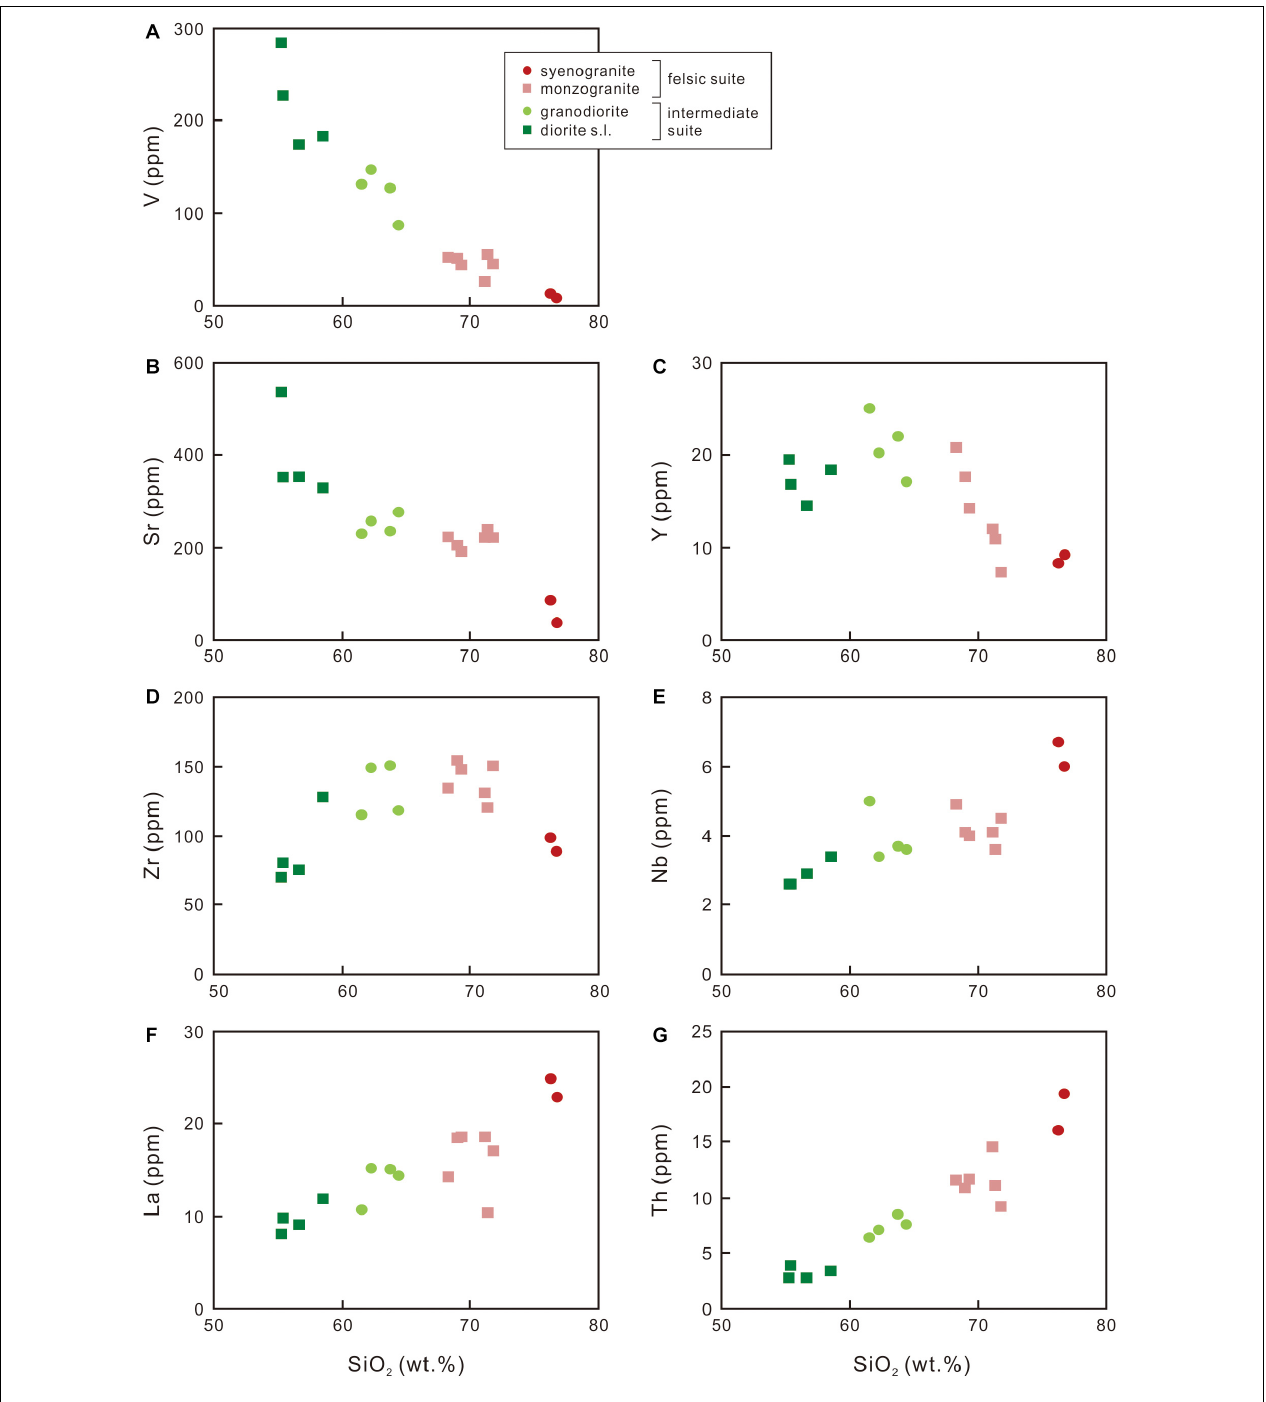
FIGURE 8 | Variations of minor or trace elements against silica for the studied samples. (A) V; (B) Sr; (C) Y; (D) Zr; (E) Nb; (F) La; (G)